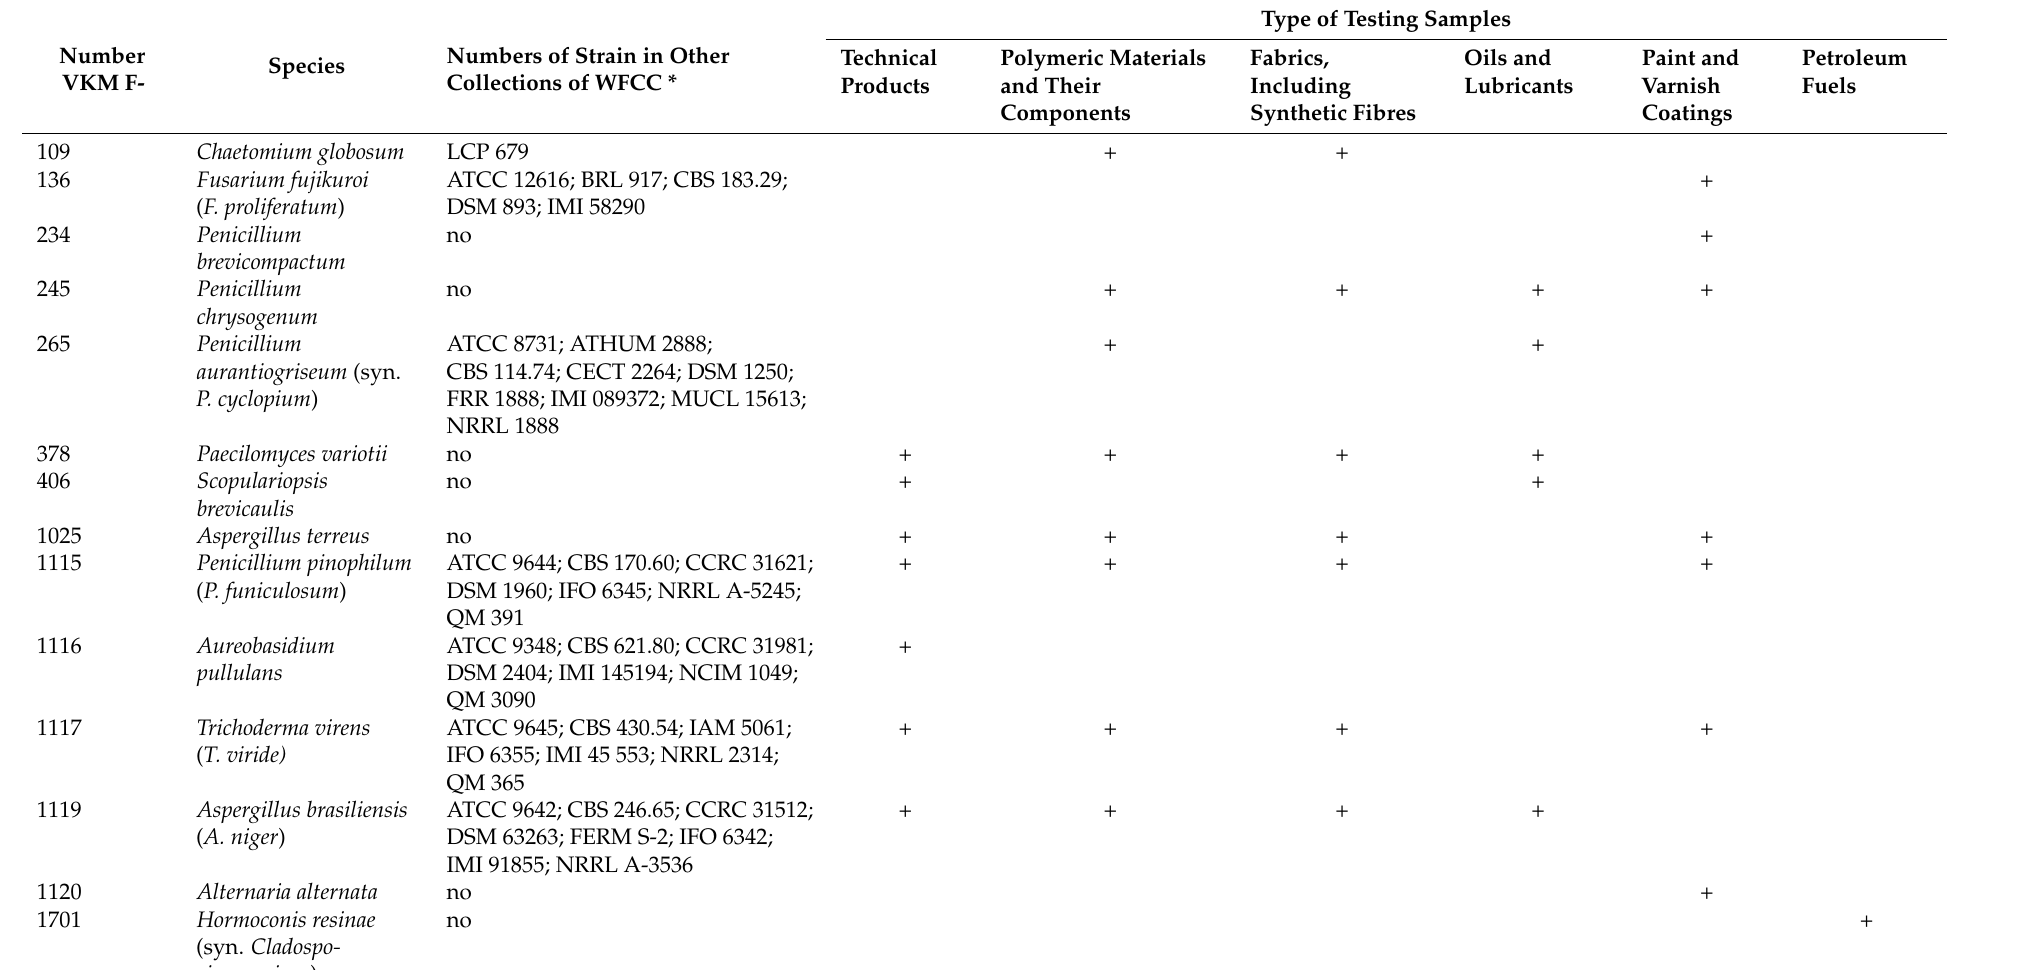
Table 3. List of strains used in mold resistance tests in